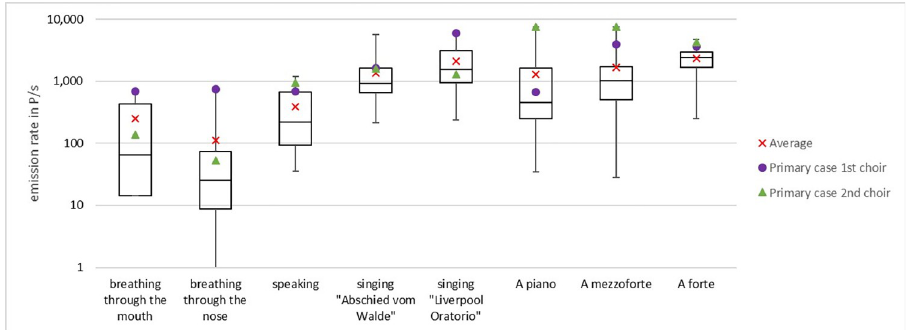
Fig 6. Box plots of cumulative particle emission rates for different activities among members of choir 1 (n = 16), Berlin, July- October 2020. Whiskers represent minimum/maximum values. Primary cases of choir 1 and choir 2 are indicated as points or triangles,